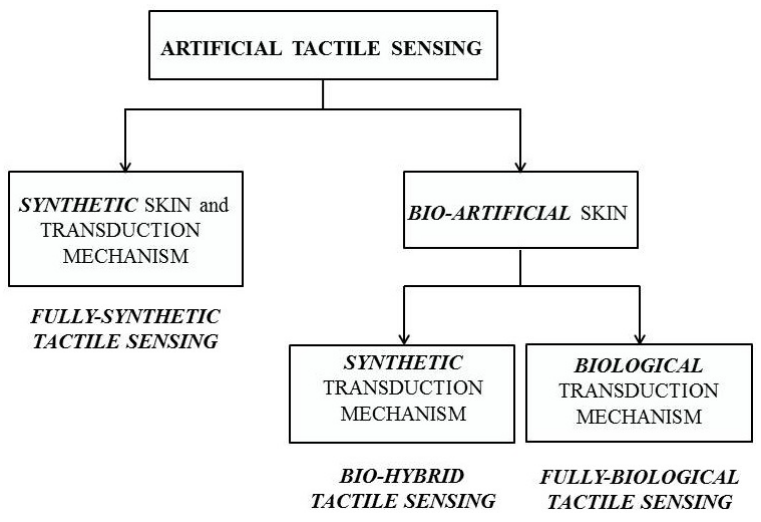
Figure 2. Classification of artificial tactile sensing with respect to the possible approaches to fabricate the outer interface skin layer and the transduction mechanism: synthetic versus bio-artificial.